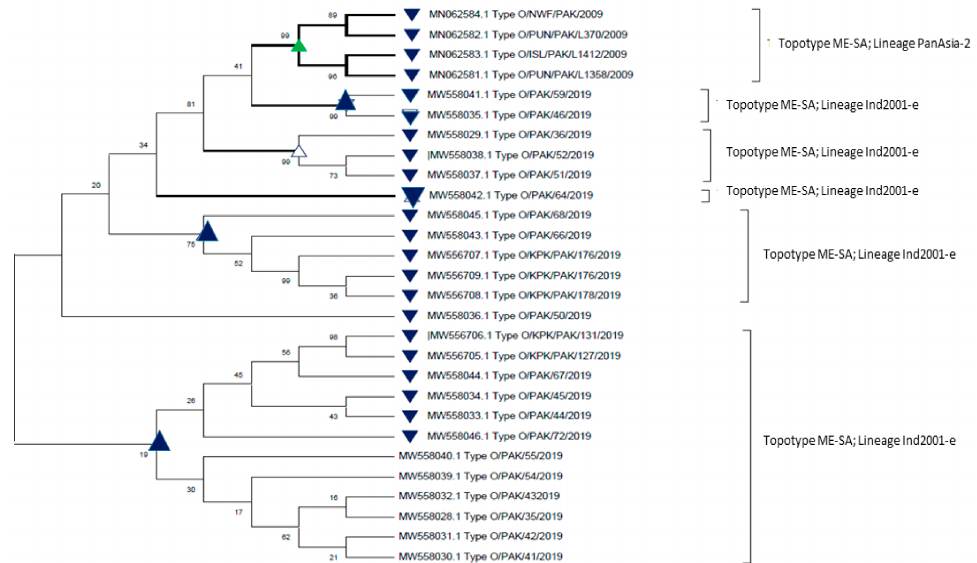
Figure 1. A phylogenetic evolutionary (rooted) tree depicting the relationship between FMDV serotype O isolates of Pakistan that have been retrieved from GeneBank. The VP1 region sequences are used for the comparison of sequences. The phylogenetic tree was constructed with maximum- likelihood method based on Tamura–Nei model. The tree topology robustness was measured with bootstrap values (100 replicates). The values on the nodes show bootstrap values.